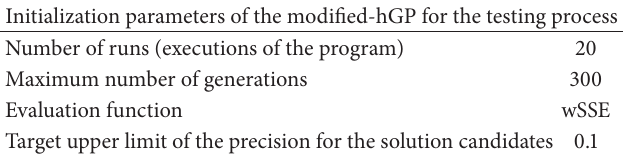
Table 15: The hGP parameters for the testing process.